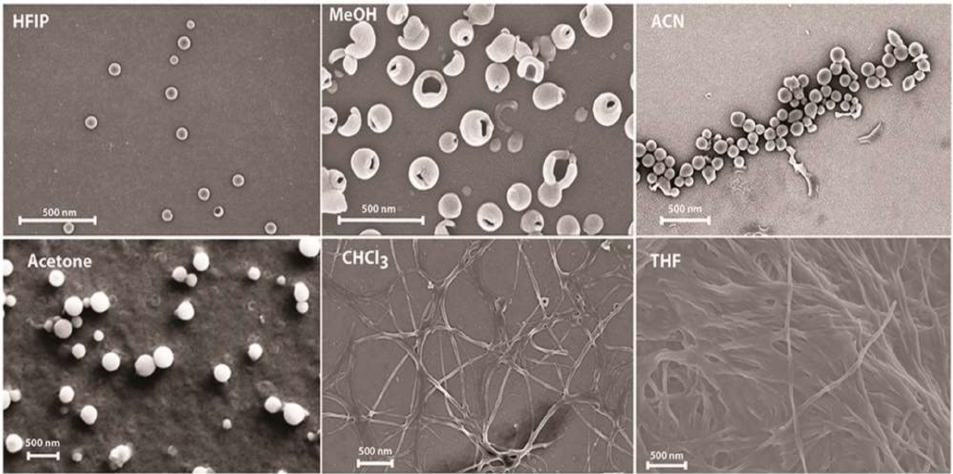
Figure 4. Field emission scanning electron microscopy (FESEM) images obtained after 72 h incubation of PDI-[FF] 2 in different solvents (10 mM) [55]. Copyright © 2018 American Chemical